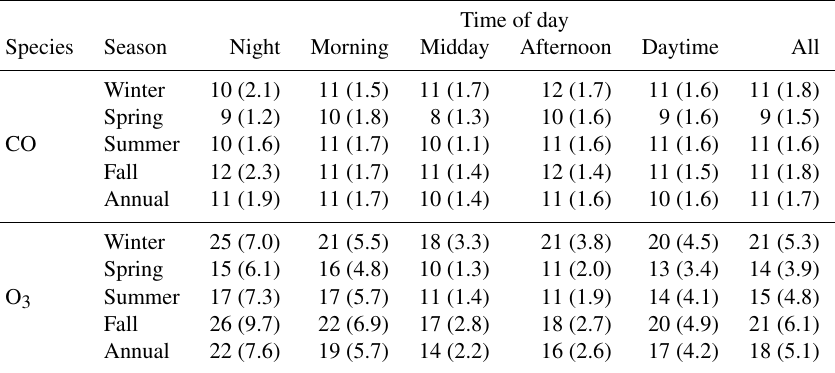
Table 2. Factors of vertical stratification γ (in %) and δ (in %hm − 1 ; in brackets) of O 3 and CO in the PLB for the different seasons and time slots (see text for details on their